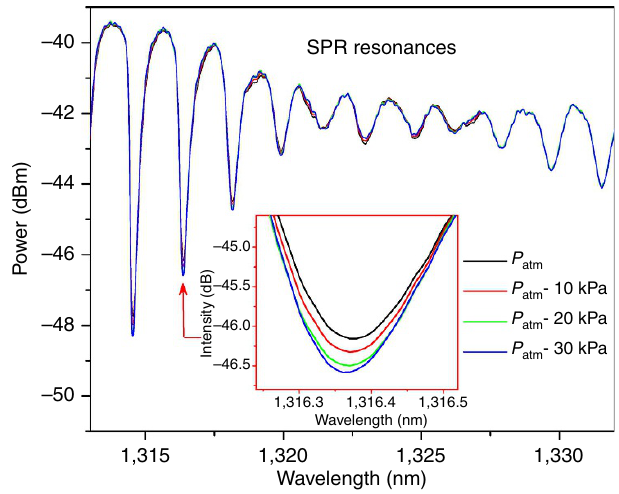
Figure 5 | P-polarized transmitted power spectrum evolution due to atmospheric pressure changes. The inset shows the evolution of the most sensitive cladding mode resonance (centred at 1,316.37nm) among those within the SPP attenuation band ( B